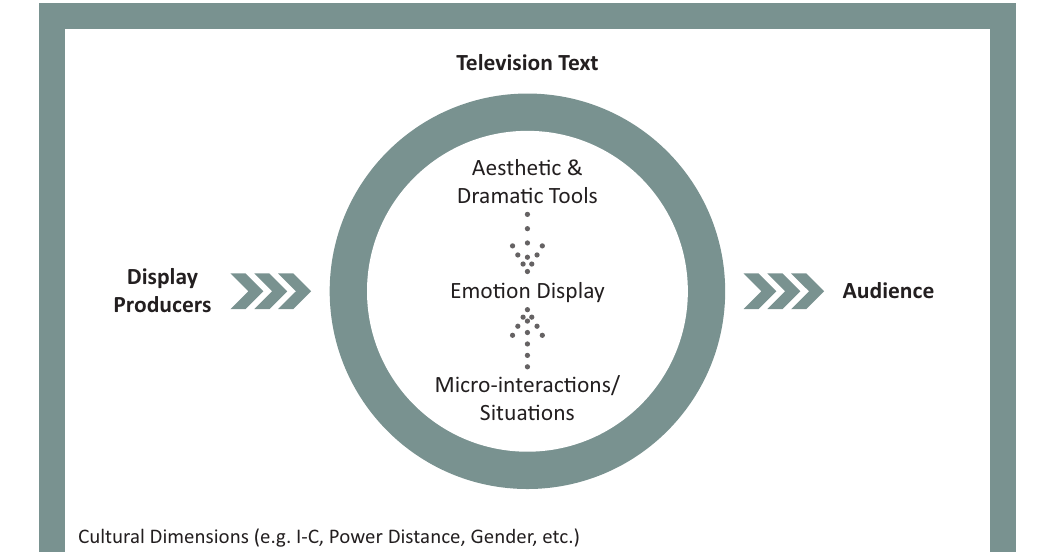
Figure 1. An analytical framework for cultural influences in emotion display in media